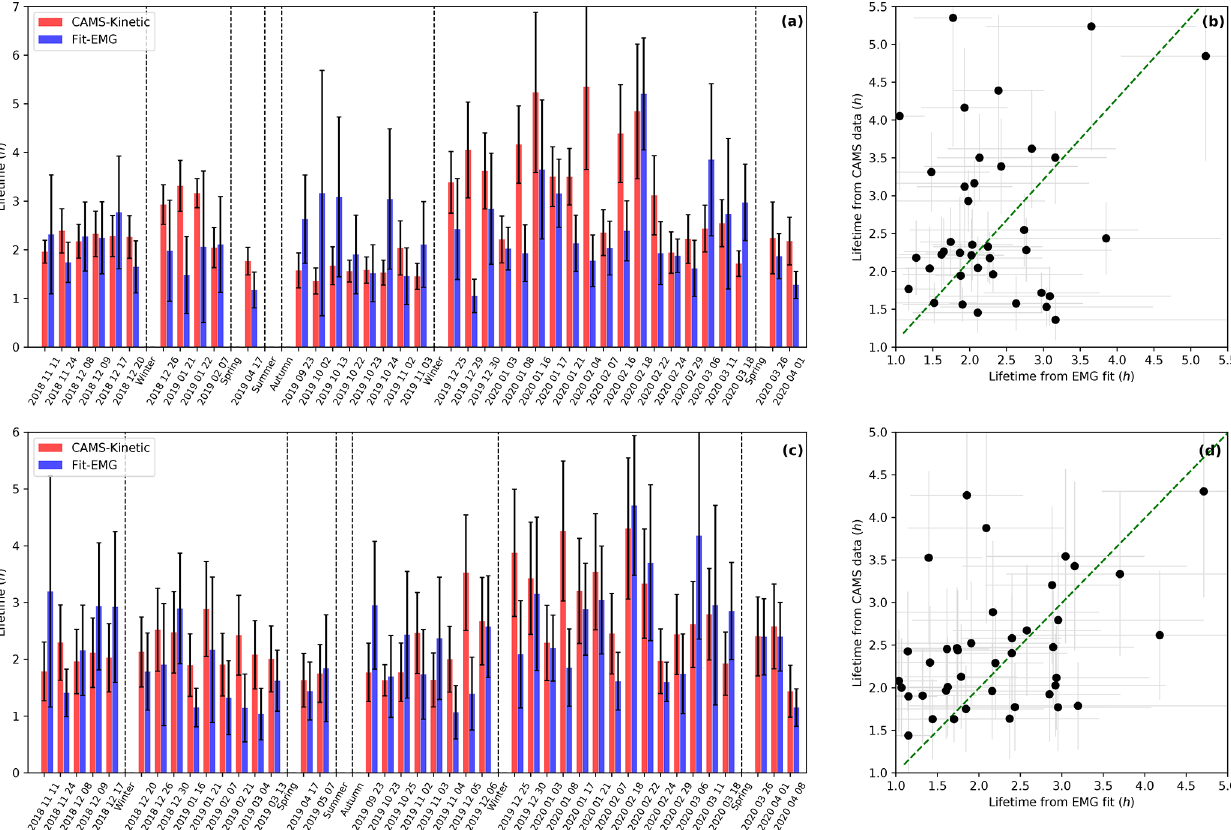
Figure 5. (a, c) Comparison between CAMS-derived NO 2 lifetimes and lifetimes from NO 2 line density fittings with EMG function above Riyadh city centre, for levels A (a) and B (c) . The samples presented correspond to patterns in clear-sky conditions for which the mean wind is in the north–south direction with a low variance, and for which the correlation between line density profile and fit gives a correlation coefficient of more than 0.97 and a lifetime of more than 1.0h. NO 2 patterns do not have these conditions during the summers of 2019 and 2020. Dashed lines separate the groups of observations by season. (b, d) Comparison between the two calculated lifetimes for levels A (b) and B (d) . A linear regression with an intercept forced to be zero is displayed with a green dashed